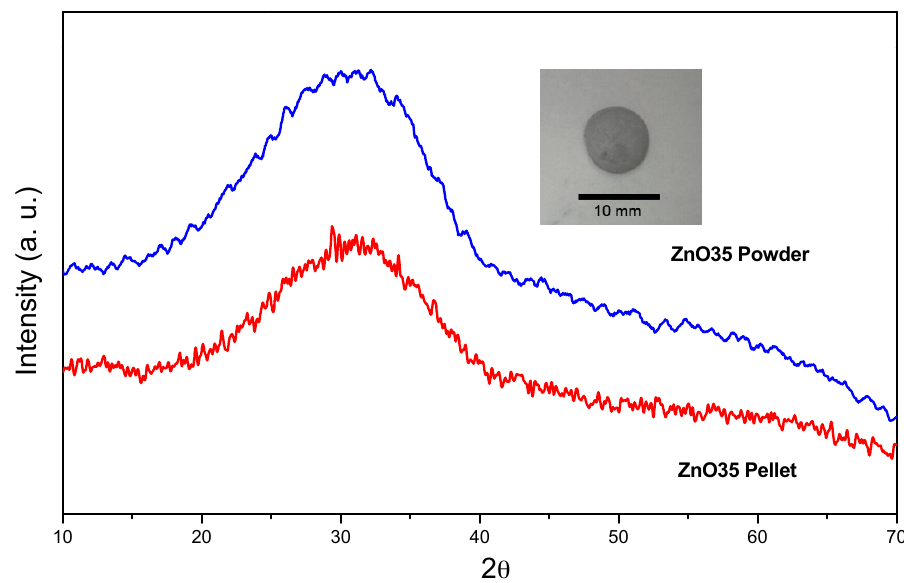
Figure 1. XRD patterns of the starting glass powders of ZnO35 and the obtained ZnO35 sintered pellets at 630 °C (insert photograph of ZnO35 pellet).